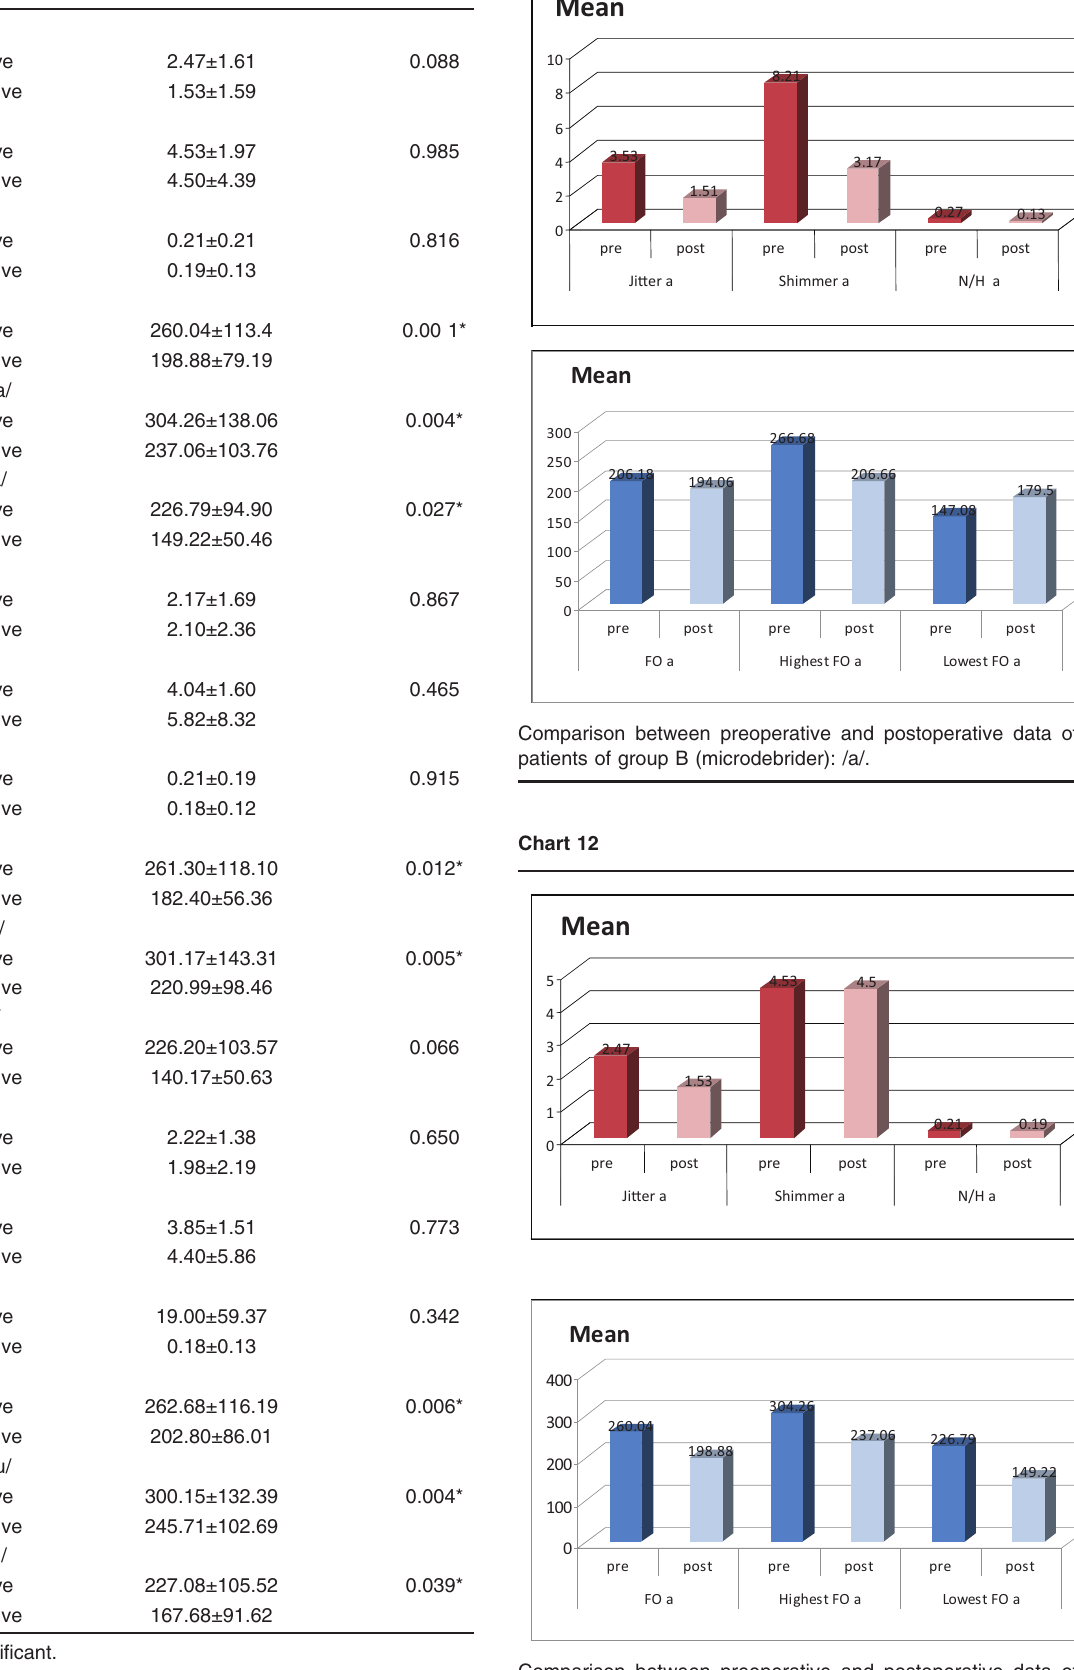
Table 11 Comparison between preoperative and postoperative data of the patients of group C (coblation) Mean±SD P